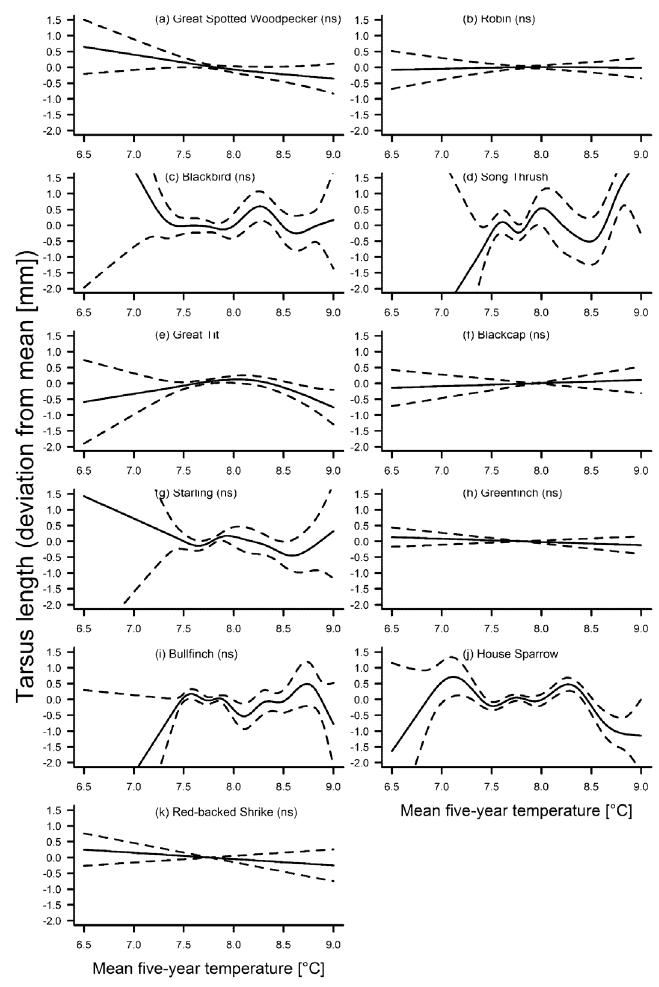
Figure 4. Fluctuations in tarsus length of eleven bird species in association with the five-year mean annual temperature. Solid line – regression spline fit from the GAM; dashed lines – 95% confidence intervals. See methods for details. A p-value of . 0.05 is indicated with (ns) after the species name, see table 3 for exact p-values.